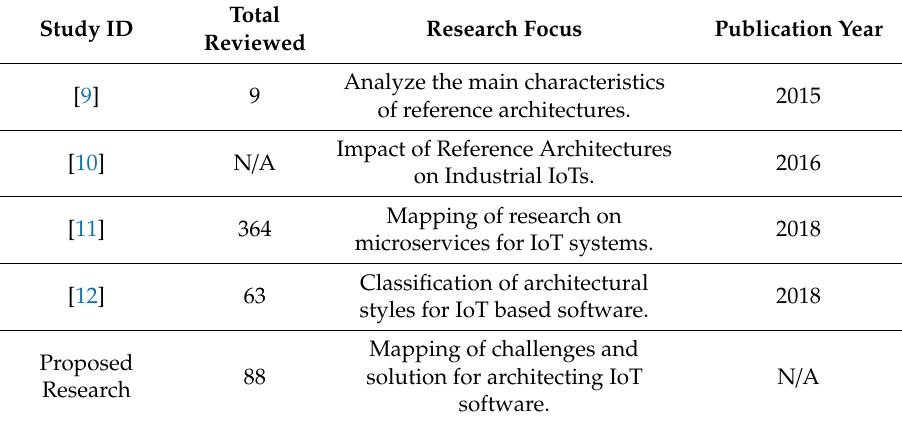
Table 1. Summary of existing secondary studies and their research